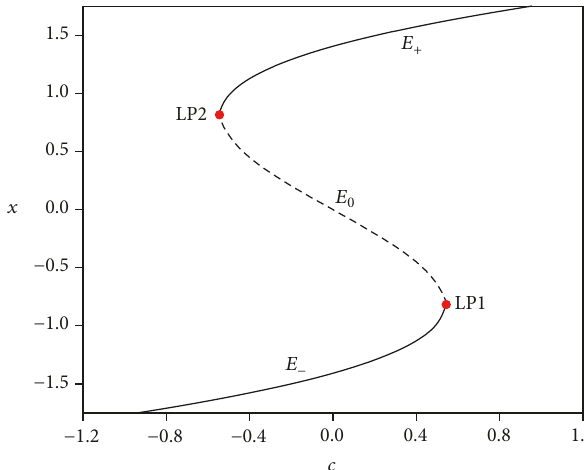
Figure 5: Distribution of the equilibria for 𝐴 = 1.0 .